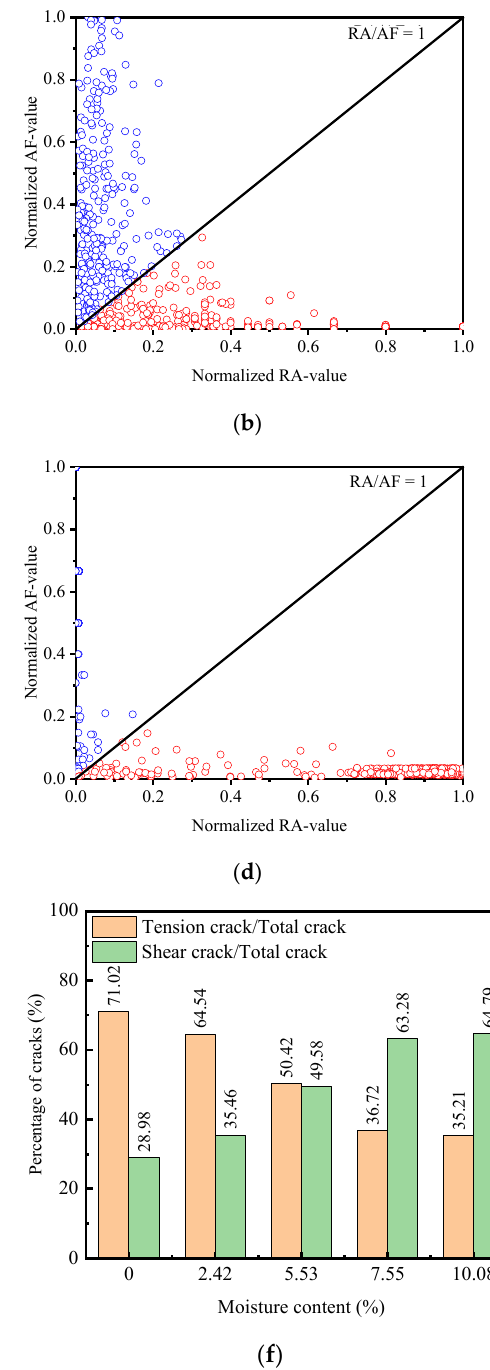
13 of 23 Figure 10. Tensile–shear crack evolution law of coal specimens under different inclination angles ( ω = 7.55%). ( a ) θ = 0°; ( b ) θ = 5°; ( c ) θ = 10°; ( d ) θ = 15°; ( e ) The proportion of tension–shear cracks in coal specimens under different inclination angles.